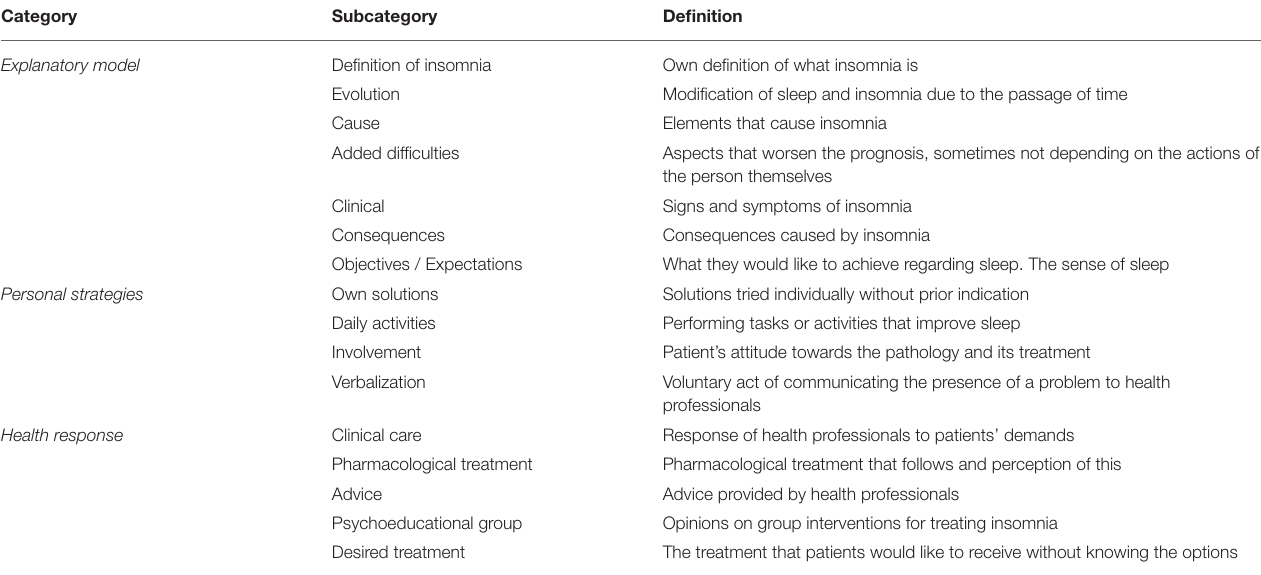
TABLE 2 | Coding. Category